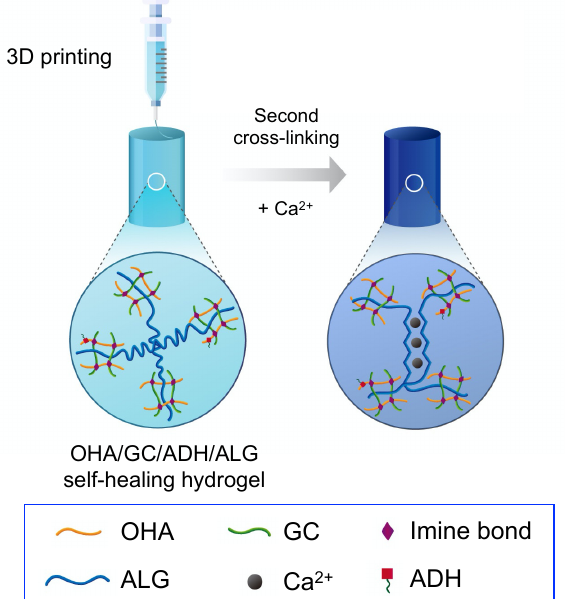
Figure 1. Schematic illustration of fabrication of dual cross-linked 3D construct using an extrusion printing method. Self-healing hydrogel was prepared from oxidized hyaluronate (OHA), glycol chitosan (GC), adipic acid dihydrazide (ADH), and alginate (ALG) by a covalent cross-linking reaction. Second cross-linking was carried out in the presence of calcium ions after the printing process.